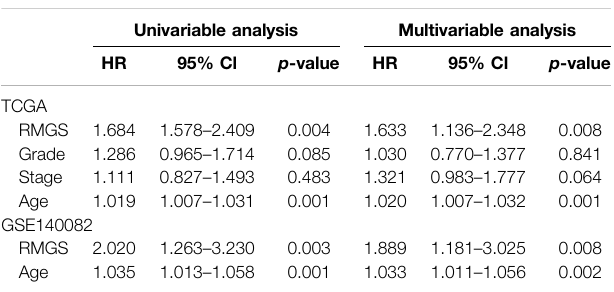
TABLE1| UnivariableandmultivariableanalysisresultsoftheRMGSinTCGAand GEO validation sets. Univariable